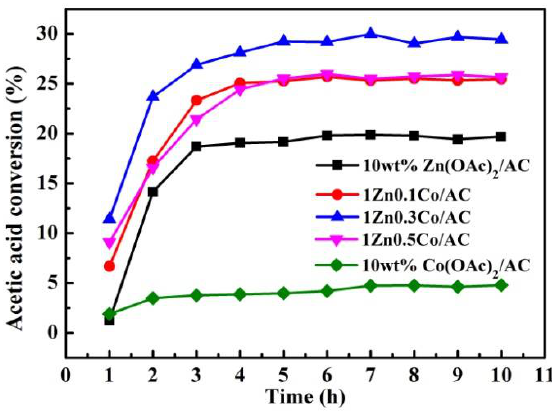
Figure 1. Conversion of HAc on the Zn-Co catalysts.